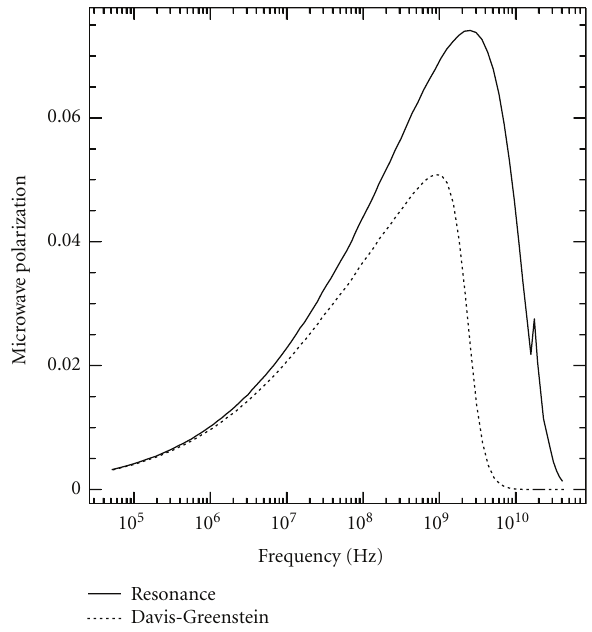
Figure 7: Polarization for both resonance paramagnetic relaxation and Davis-Greenstein relaxation for grains in the cold interstellar medium as a function of frequency (from LD00). For resonance relaxation the saturation e ff ects are neglected, which means that the upper curves correspond to the maximal values allowed by the resonant paramagnetic